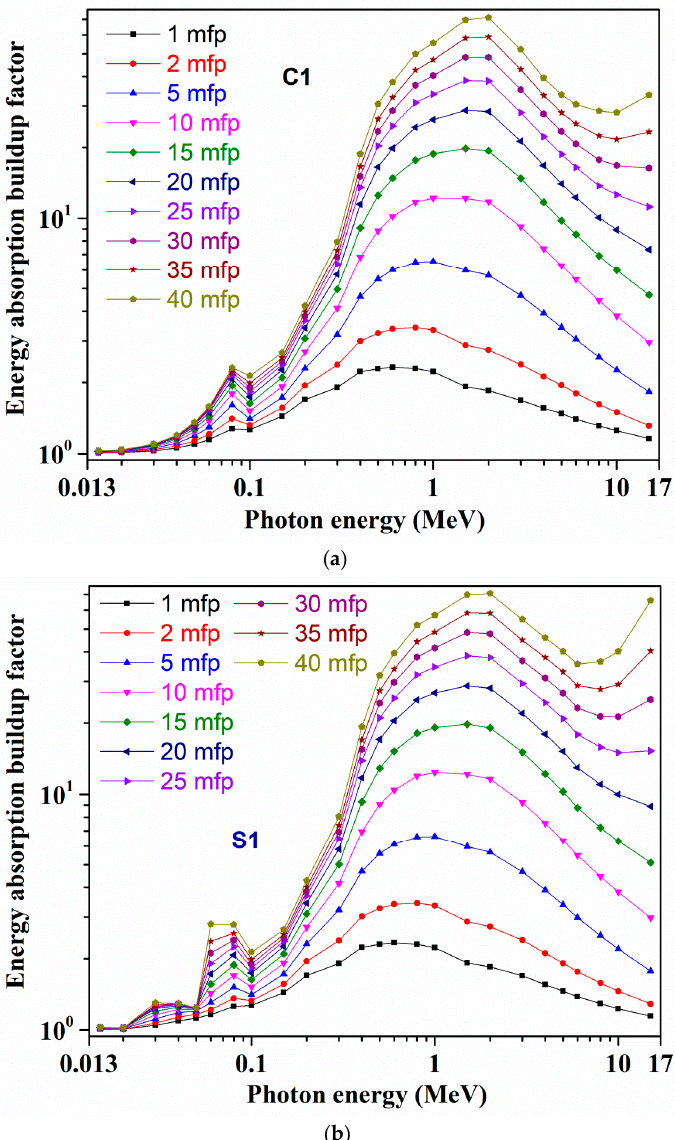
Figure 5. Variations of energy absorption buildup factor (EABF) with photon energy at different mean free paths for ( a ) C1 and ( b ) S1 glasses. For all C1–C6 and S1–S6 samples (thickness, t = 1 cm), Figure S11 in the Supplemen-